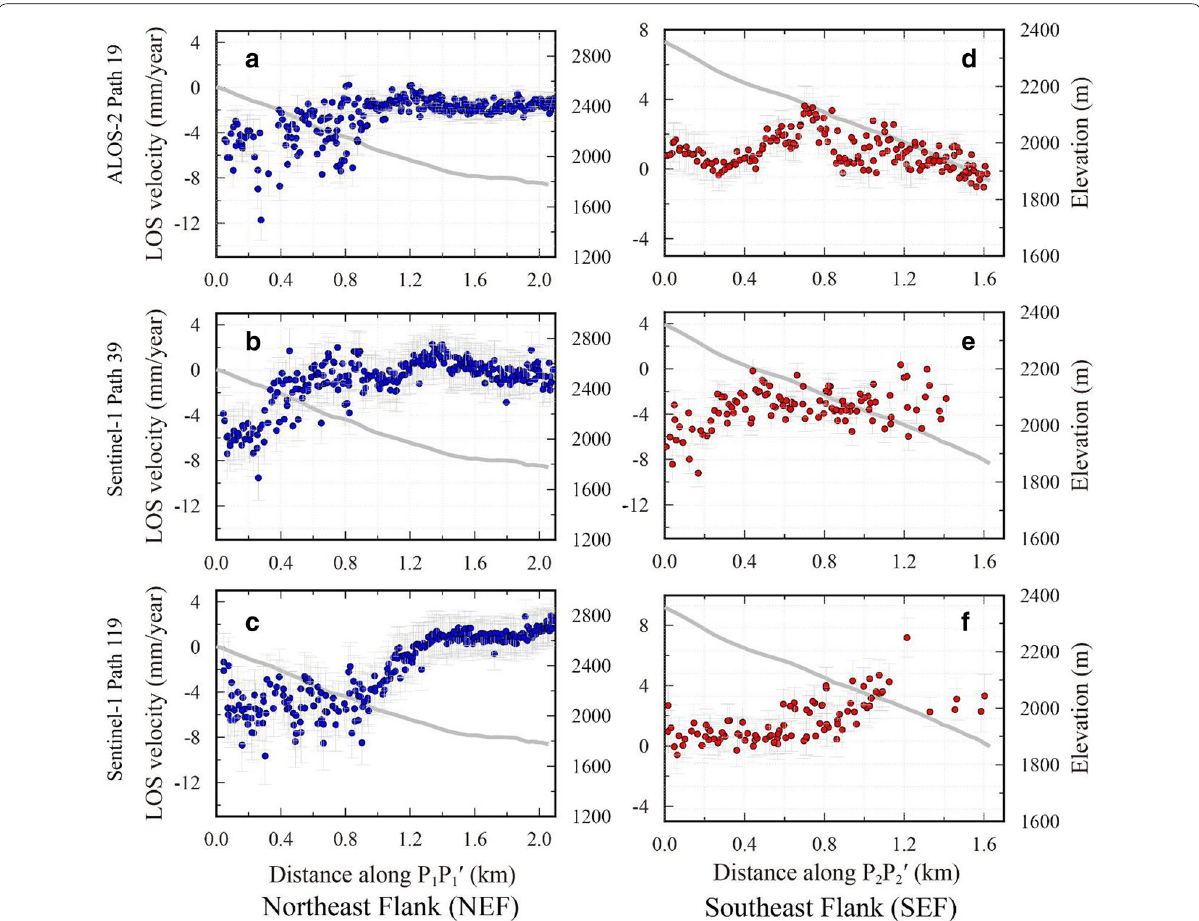
Fig. 8 LOS velocities along the two profiles P 1 P 1 ′ and P 2 P 2 ′ (Fig. 7a) that encompass NEF and SEF, respectively. LOS velocities along P 1 P 1 ′ from the a ALOS-2, b ascending Sentinel-1, and c descending Sentinel-1 images. d – f Similar to a – c but for the profile P 2 P 2 ′ . Note the positive velocity represents LOS shortening, and the negative velocity represents LOS extension. Error bars represent the estimated uncertainties (Additional file 1: Fig. S4) for deformation